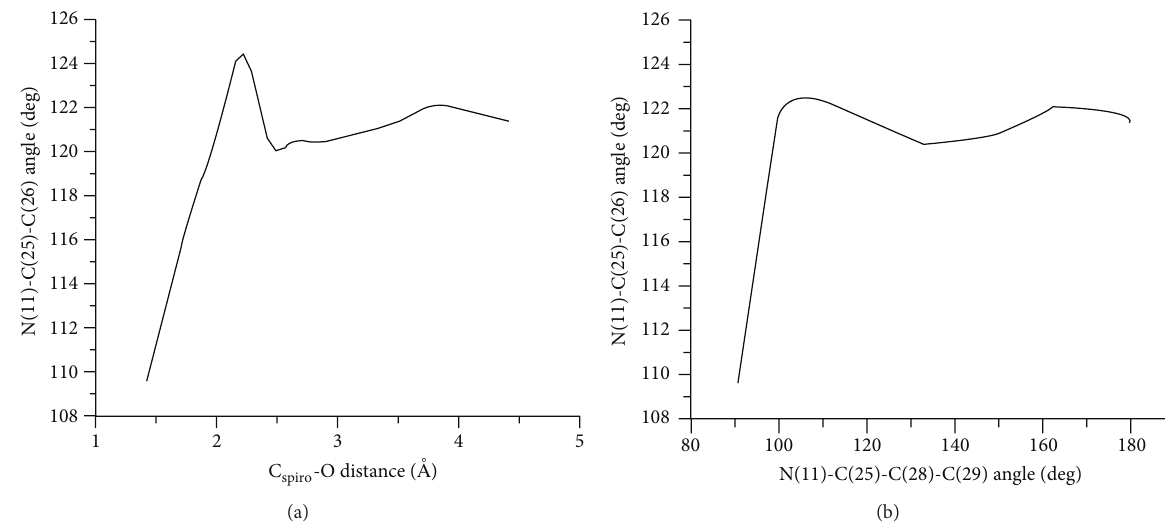
-O bond (a) and from dihedral angle N(11)-C(25)- spiro